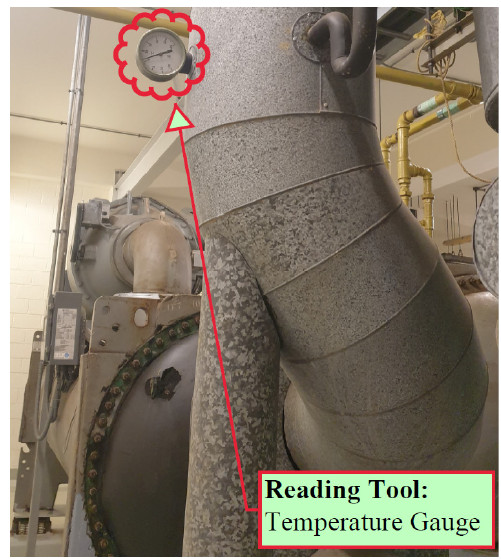
Figure 4. Chiller Reading Tool.